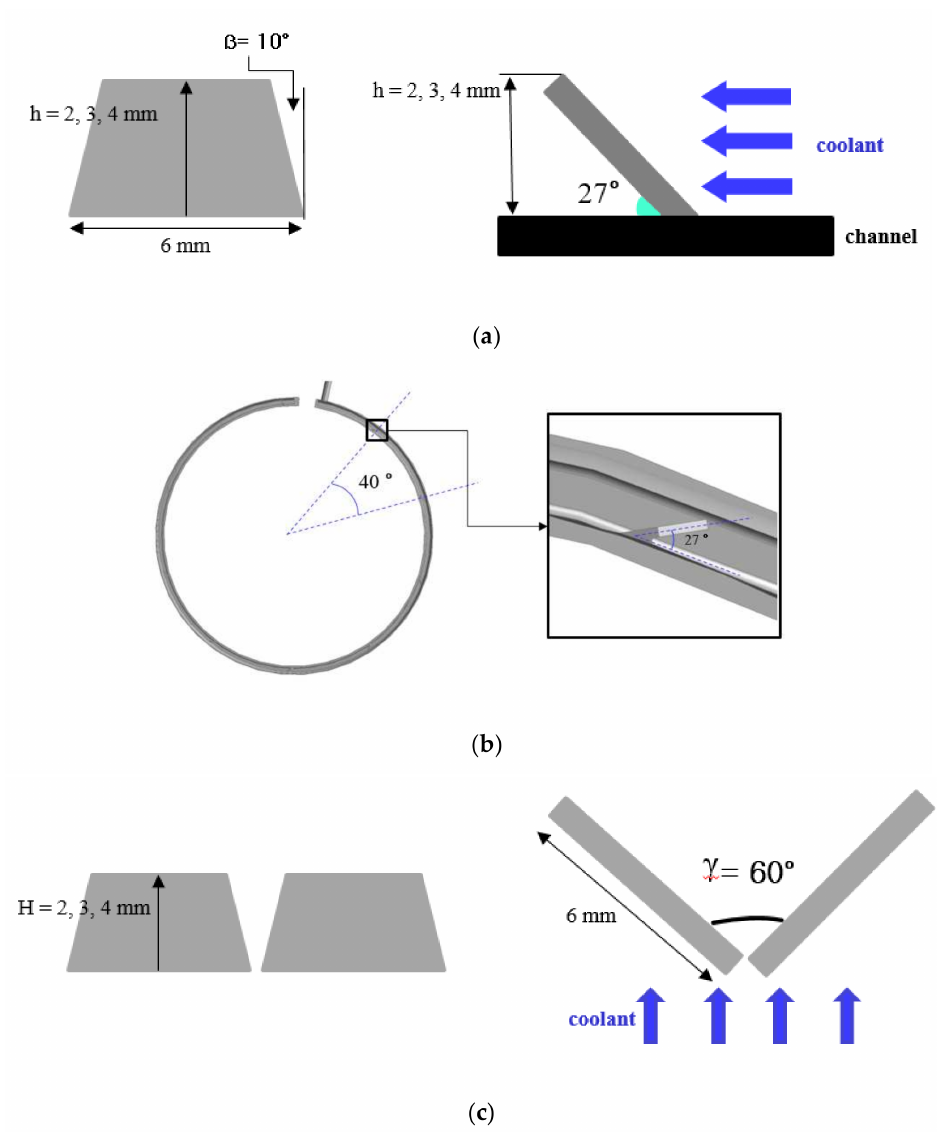
Figure 3. Flow mechanism and variables of enhanced models with vortex generators: ( a ) Front view and side view of single-vortex generator; ( b ) side view of water channel with single-vortex generator; ( c ) Front view and top view of pair-type vortex